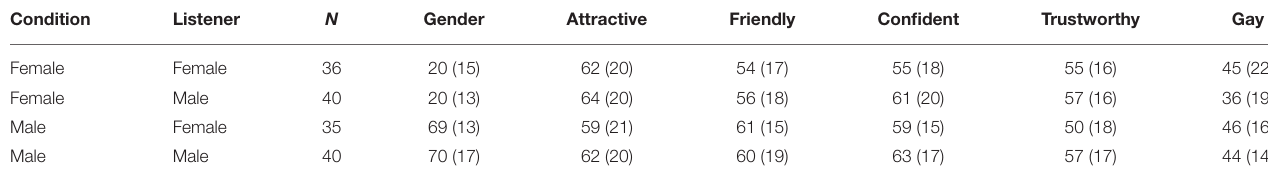
TABLE 4 | Mean ratings (and standard deviations in parentheses) for perceived visual gender, attractiveness, friendliness, confidence, trustworthiness, and gayness in the two face conditions arranged by the gender of the participants. Condition